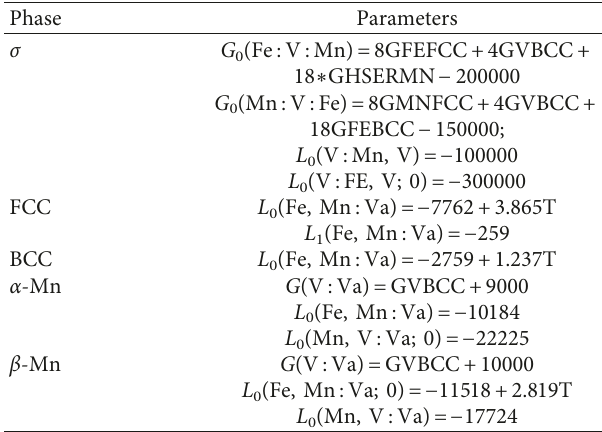
Table 1: Chemical composition of alloys and their phase com- position after annealing.